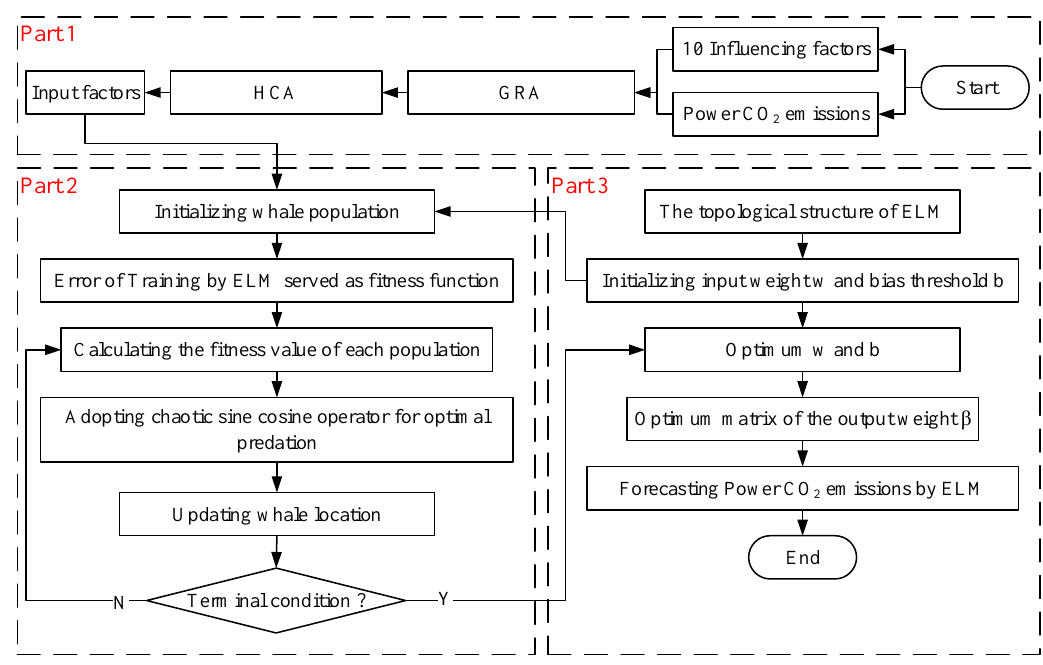
Figure 2. Application process of the extreme learning machine optimized by whale algorithm based on chaotic sine cosine operator (CSCWOA-ELM) model.